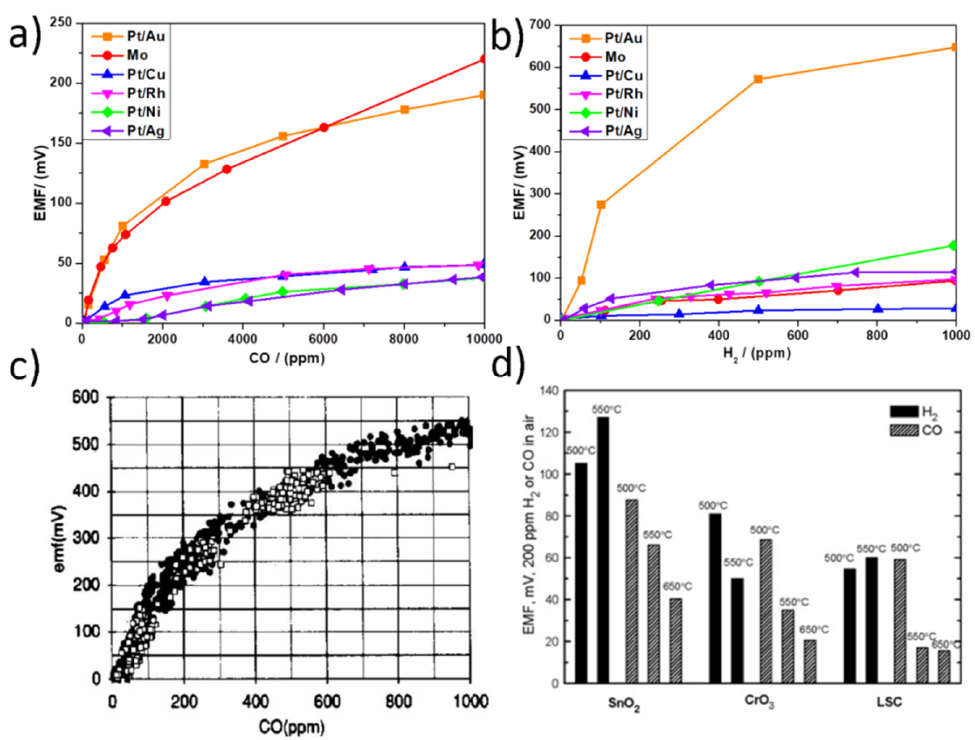
Figure 3. EMF response for the different SEs with 8% O 2 in the flue gas and ( a ) CO concentration ranging from 0 to 10,000 ppm and ( b ) H 2 concentration ranging from 0 to 1000 ppm. ( c ) The long-term stability of the EMF characteristic for a solid electrolyte sensor using Pt/Au working electrode and tested in a chimney of a 7MW commercial burner (black dots—1st day, white dots—after 2 months). (Data reproduced with permission from [27]. Copyright ©1993 Elsevier. All rights reserved.) ( d ) EMF responses of SnO 2 , Cr 2 O 3 , and LSC electrodes in 200 ppm H 2 in air or 200 ppm CO in air, at 500, 550, and 650 °C. (Data reproduced with permission from [28]. Copyright ©2013 Elsevier. All rights reserved.)